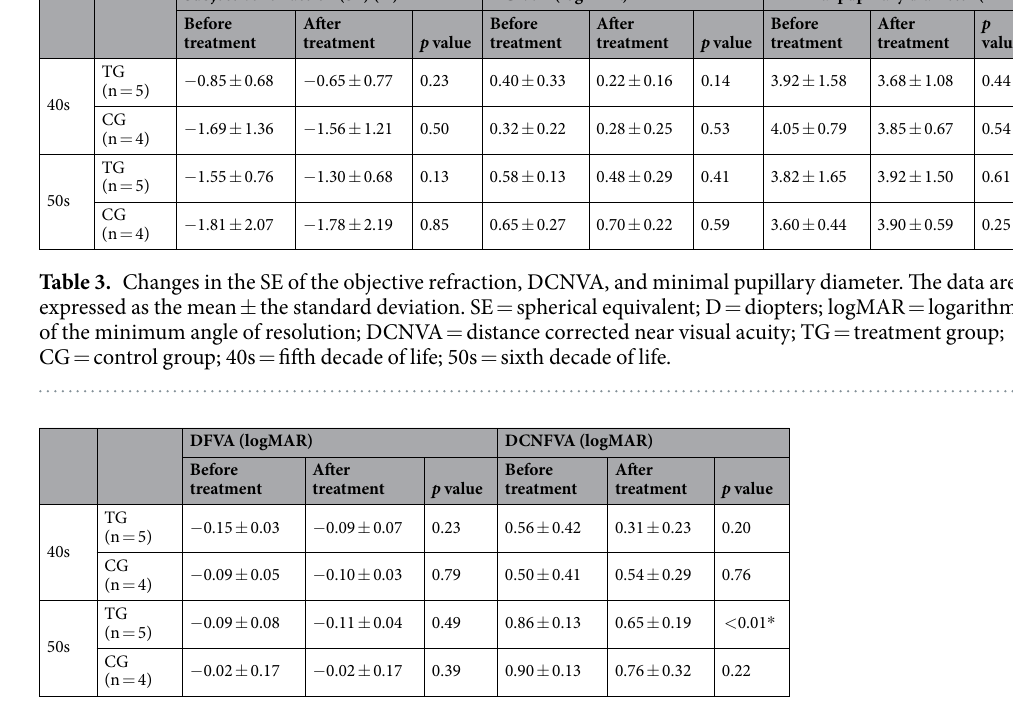
Table 4. Changes in the DFVA and DCNFVA. The data are expressed as the mean ± standard deviation. * Significant correlation ( p < 0.05 with the Bonferroni correction). DFVA = distance functional visual acuity; DCFVA = distance corrected near functional visual acuity; logMAR = logarithm of the minimum angle of resolution; TG = treatment group; CG = control group; 40s = fifth decade of life; 50s = sixth decade of